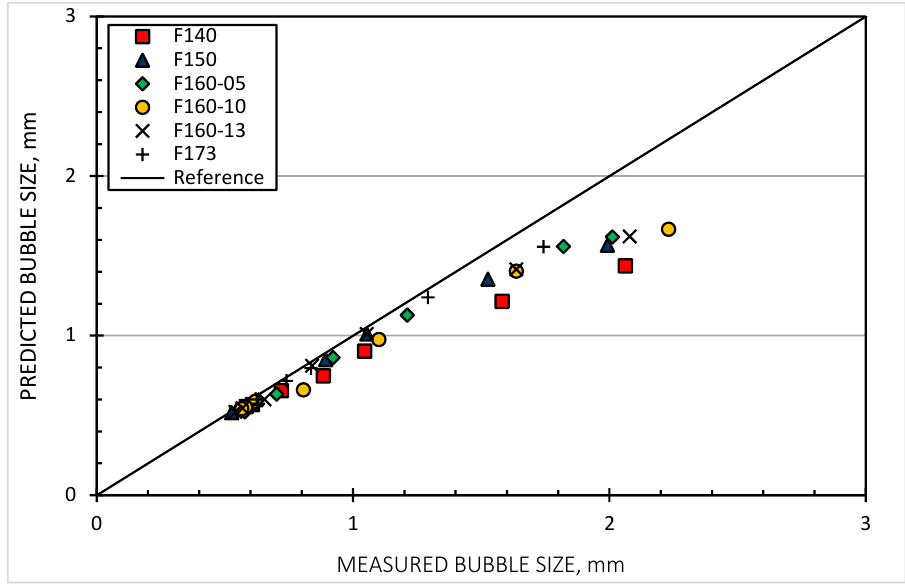
Figure 8. Predicted vs. measured bubble size (drift-flux model).